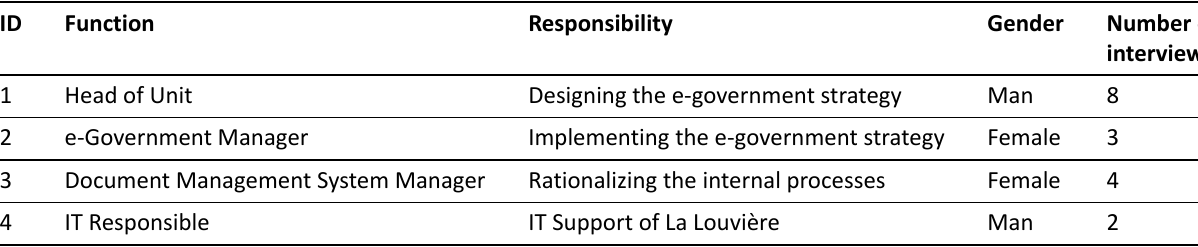
Table 1. Interviewees.